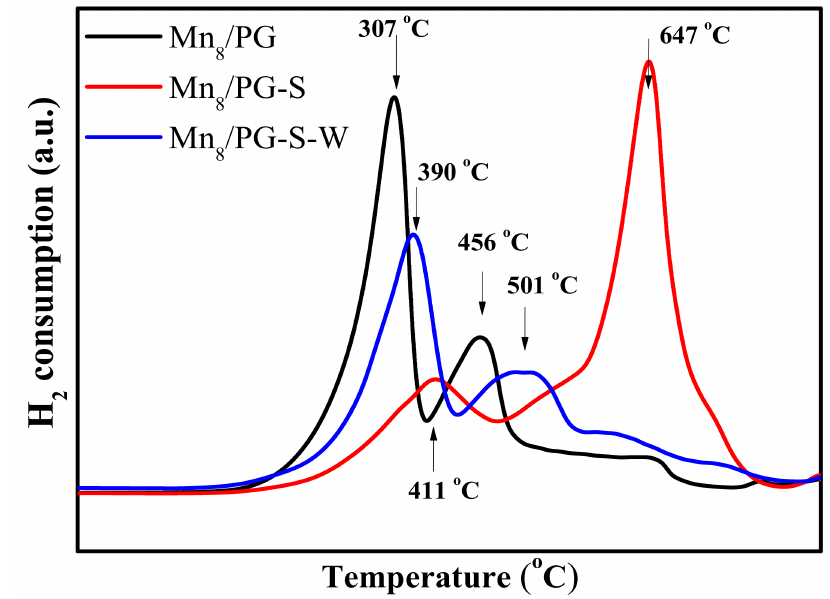
Figure 6. H 2 -temperature-programmed reduction of different